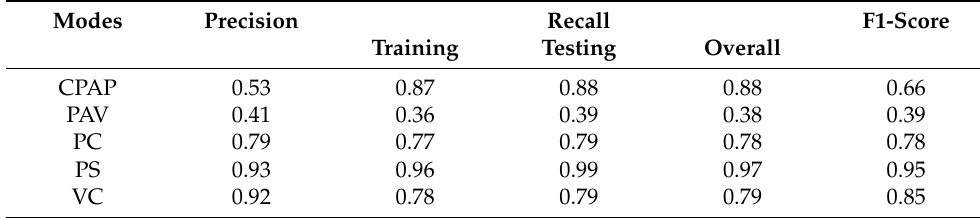
Table 9. Model evaluation report for GaussianNB algorithm.